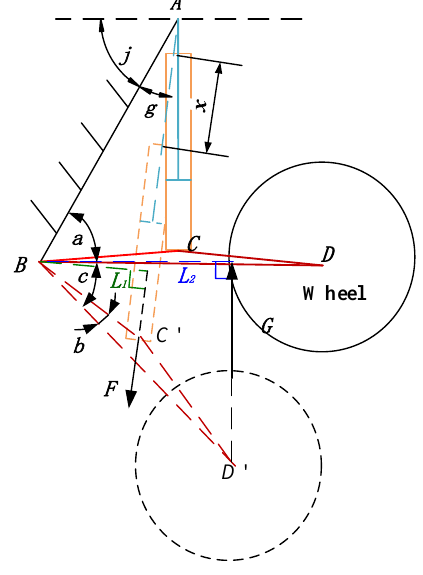
Figure 3. The simplified mechanism.